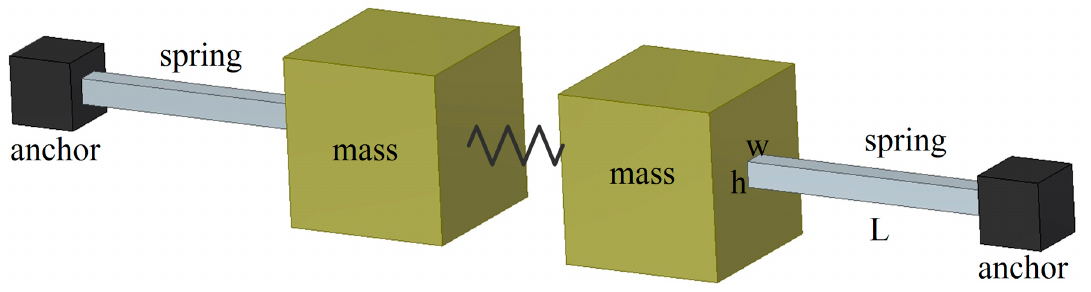
Figure 2. Simplified spring-mass structure.